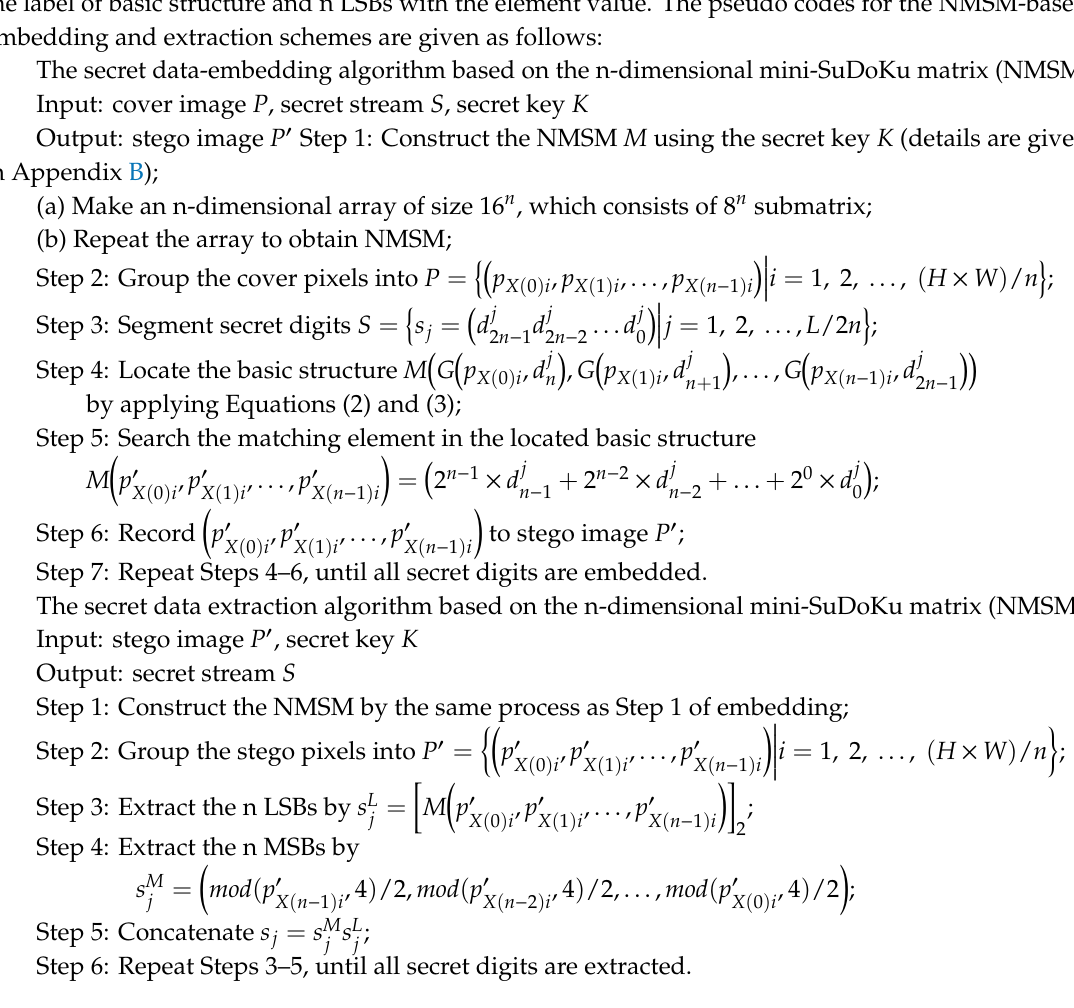
Fast Algorithm for the Inner Embedding Layer (details are given in Appendix